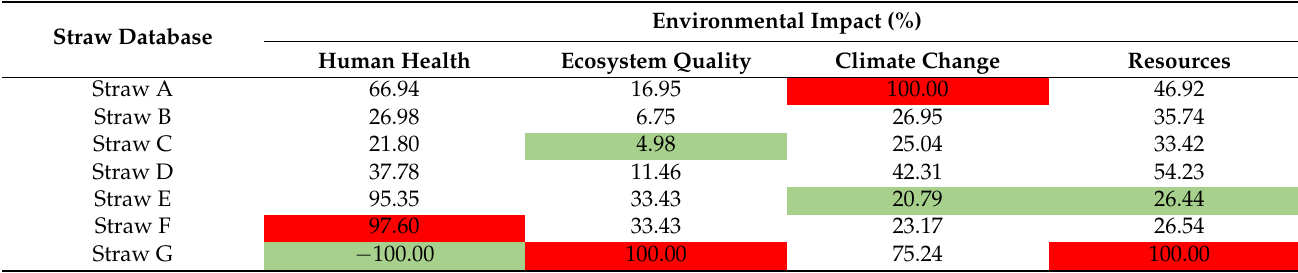
Table 5. Relative percentage comparison of individual straw alternatives environmental impact. For each impact category the worst and the best straw alternative was highlighted according to the highest contribution within individual